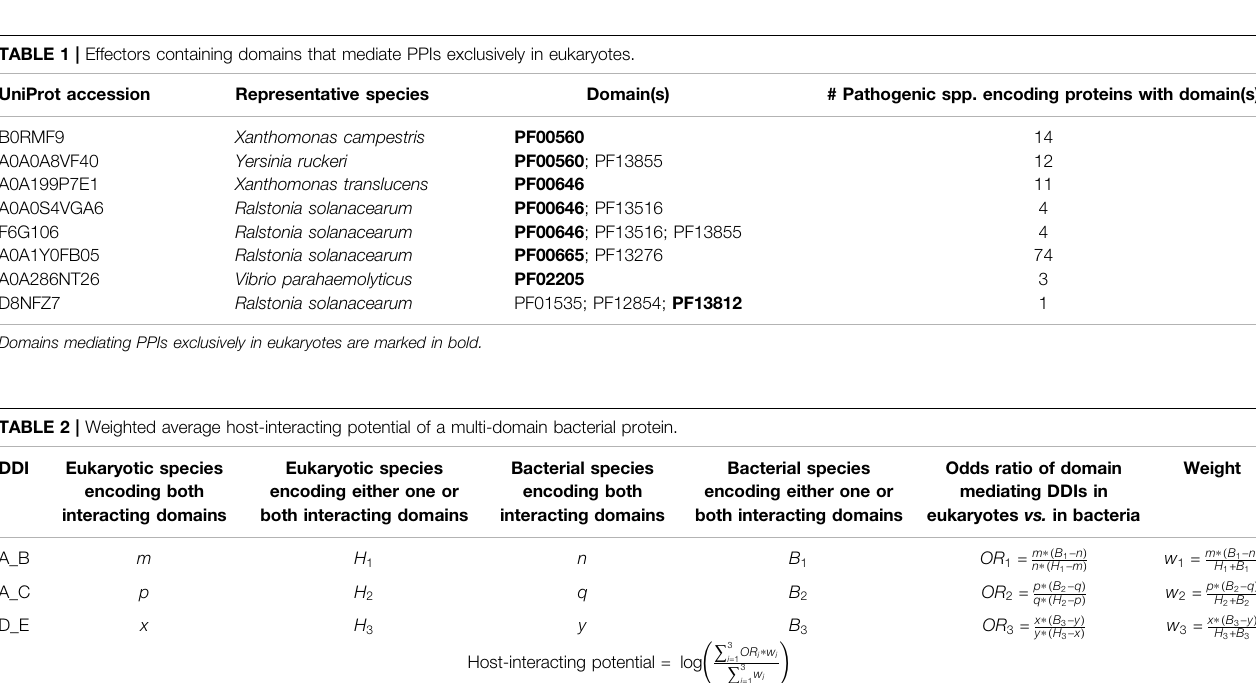
( Figure 2 ). Table 1 is a list of effectors containing domains involved in interprotein DDIs in eukaryotes, but neither interprotein nor intraprotein DDIs in bacteria. Next, we tested the hypothesis that effectors are enriched for domains that mediate DDIs primarily in eukaryotes. For domains having